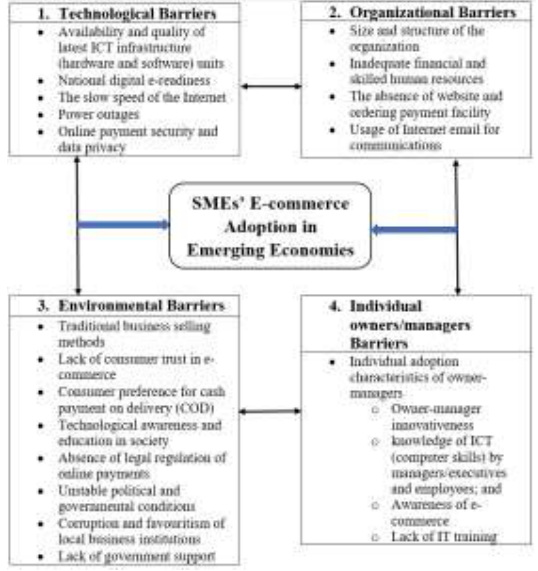
Figure 1. Barriers for SMEs to adopt E-commerce in Emerging Economies - A